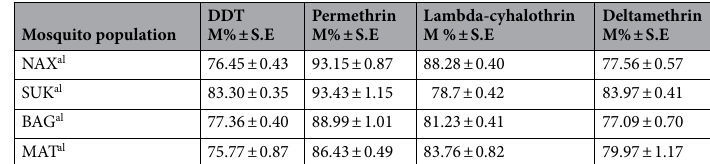
Table 1. Insecticide resistance profile of Ae. albopictus (n ≥ 100) from northern part of West Bengal, India against DDT and synthetic pyrethroids. M%, mortality percentage; S.E., standard error; n, total number of adult mosquitos; al, Aedes albopictus population.